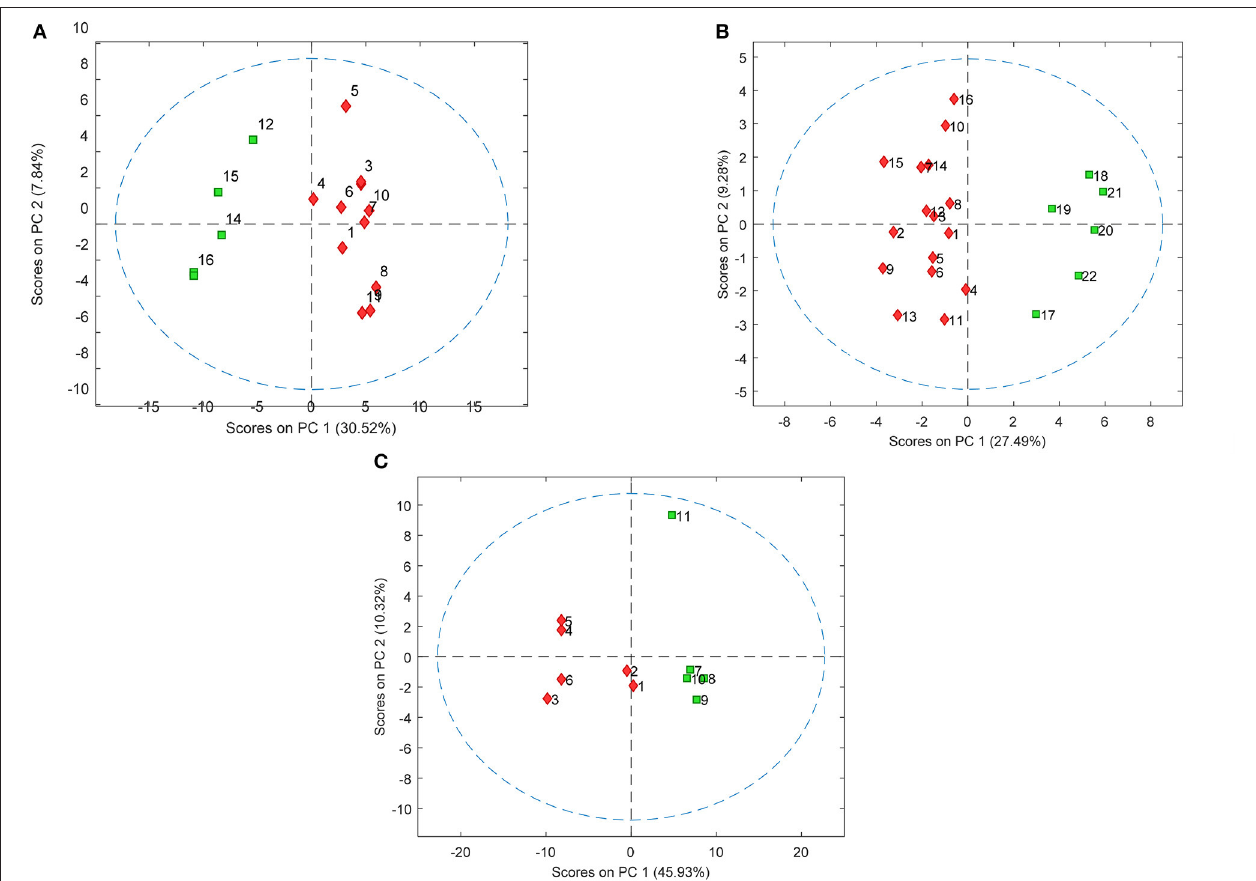
FIGURE 1 | PCA plots showing separation of patients who either responded or did not respond to (A) olanzapine, (B) risperidone, and (C) quetiapine treatment using baseline plasma lipid levels (each symbol represents a patient sample). Responders and non-responders are represented in red and green,